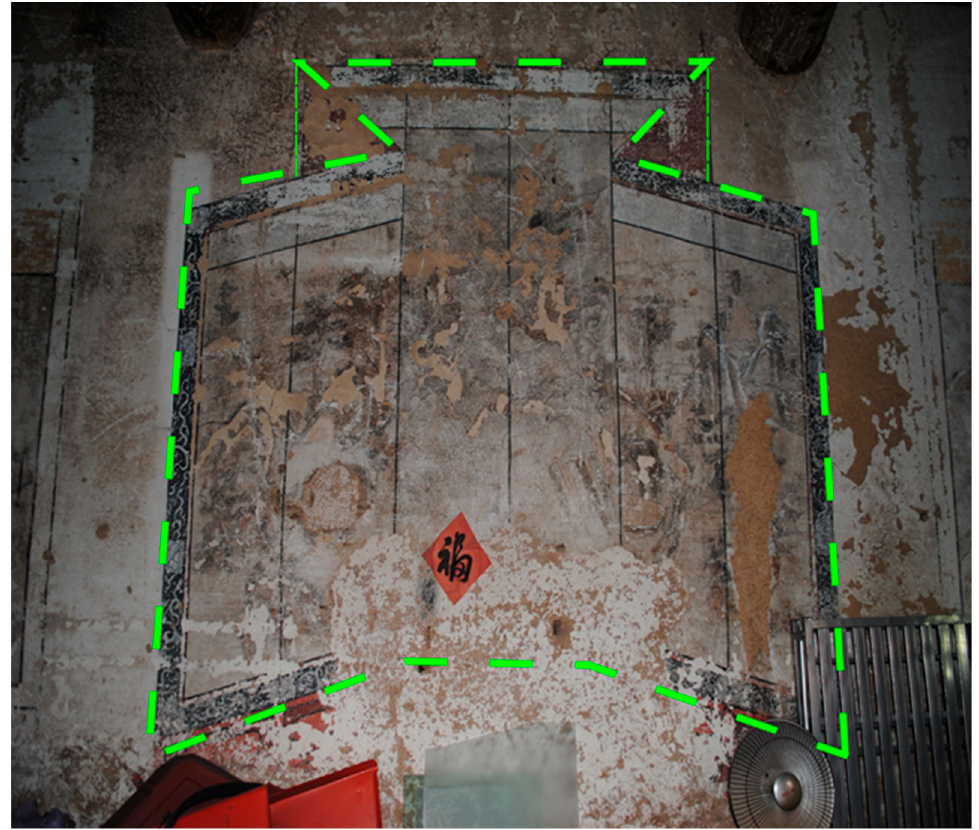
Figure 10. A 6 ‐ screen folding screen in Guandi Temple in the Nanyang Village, Yechuan Town